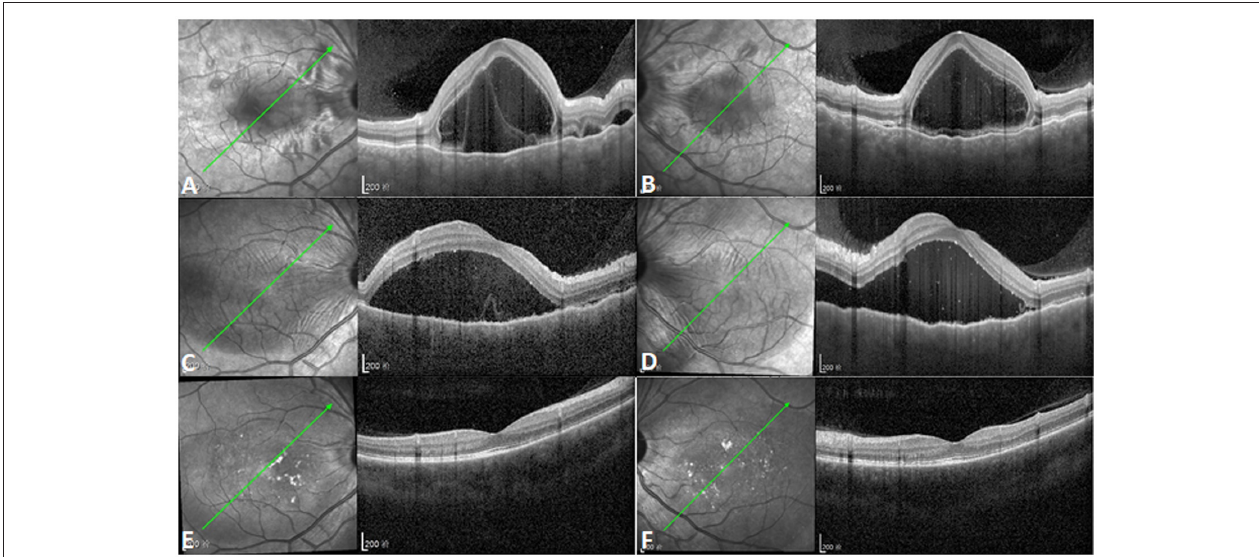
FIGURE 2 | Increased subretinal fluid after initial corticosteroid therapy. (A,B) Optical coherence tomography (OCT) showing multifocal serous retinal detachments with choroidal effusion in both eyes (left illustrations indicate the orientation of OCT scanning profile). (C,D) Subretinal fluid (SRF) increased and the coalescence of previous multifocal serous retinal detachments was observed in both eyes after initial corticosteroid therapy [left illustrations indicate the orientation of OCT scanning profile, and point-to-point follow-up mode was used for (A,C) , (B,D) ]. (E,F) OCT showing complete absorption of SRF with normal macular structure 6 months after the onset of Vogt-Koyanagi-Harada disease [left illustrations indicate the orientation of OCT scanning profile, and point-to-point follow-up mode was used for (A,E) , (B,F) ].